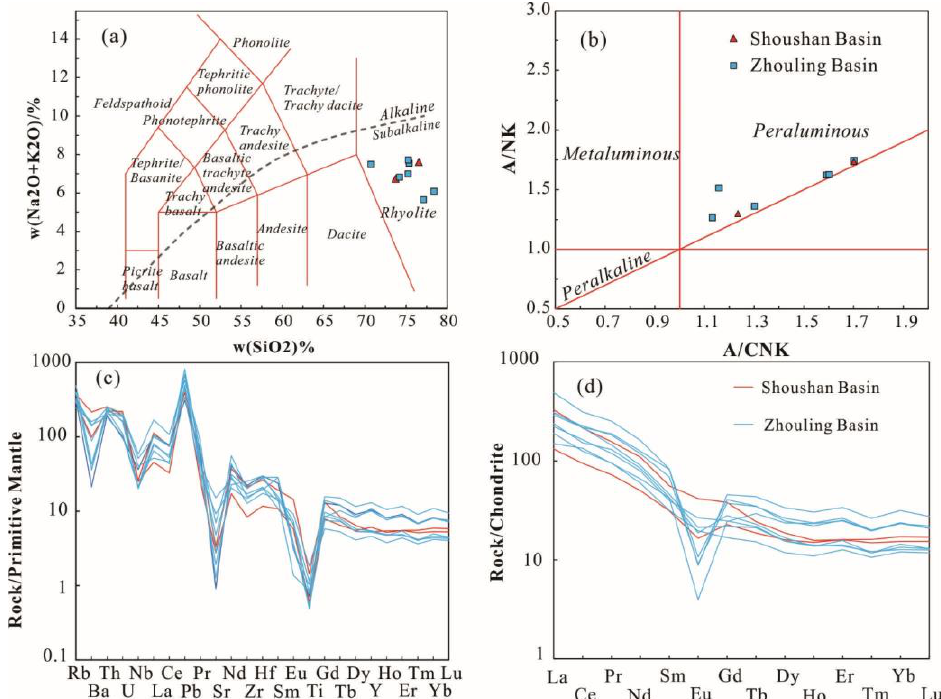
Figure 8. ( a ) Total alkali versus silica (TAS) classification diagram. ( b ) Molar Al 2 O 3 /(CaO + Na 2 O + K 2 O) versus molar Al 2 O 3 /(Na 2 O + K 2 O) diagram. ( c ) Primitive-mantle-normalized multielement patterns. ( d ) Chondrite-normalized REE patterns of volcanic rock in the Shoushan basin and Zhouling basin. The REE compositions of chondrite are from Sun and McDonough [38 ].